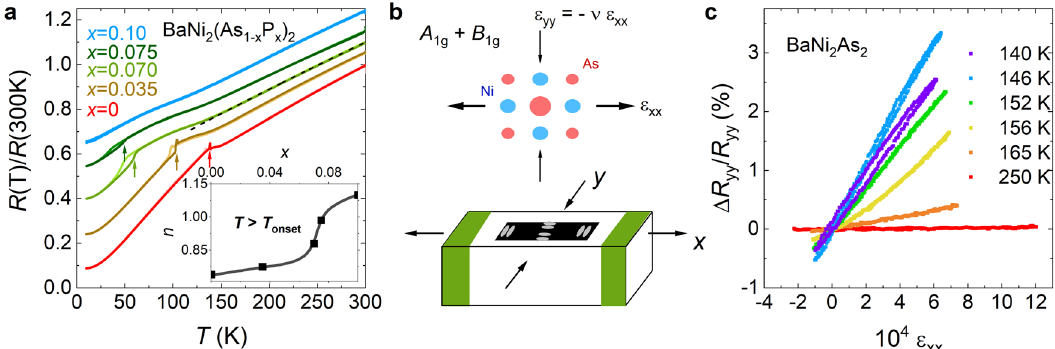
Fig. 1 Characterization and elastoresistance measurements of BaNi 2 (As 1 − x P x ) 2 single crystals. a Normalized resistance, R ( T )/ R (300K), at the indicated x values. Cooling and warming measurements are depicted as light and dark colors, respectively. The curves are vertically shifted for clarity. The arrows indicate the triclinic transition temperatures upon warming, and the dashed black line is a high temperature fi t to R = R 0 + AT n for T > T onset ( T onset being the onset temperature of the elastoresistance, see main text). The inset shows the evolution of the n exponent on substitution level. b Schematic of an elastoresistance experiment: the sample (black rectangle) is glued on top of a piezo with its [100] tet axis along the piezo poling direction, x . Application of a positive voltage to the piezo leads to a tensile strain along the poling direction and a compression in the orthogonal axis through Poisson effect. Both R xx (so-called longitudinal) and R yy (transverse) electrical resistances are measured, using the piezo frame notation. The corresponding A 1g + B 1g strain state of the basal plane is also shown. c Representative resistance variation with strain in transverse geometry for x = 0 at selected temperatures. The elastoresistance signal is strongest at T * ≈ 146K while an hysteretic behavior is more pronounced at lower